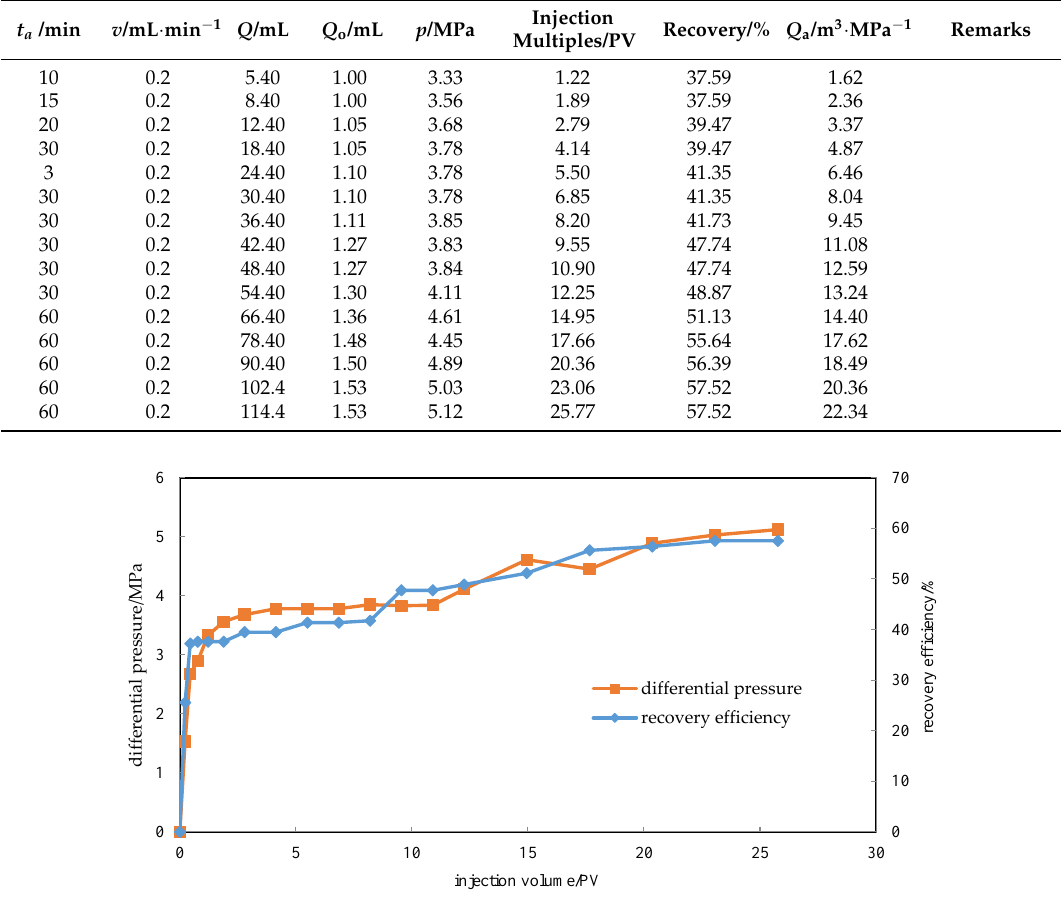
Table 12. The core 32 physical property parameters and experimental conditions.